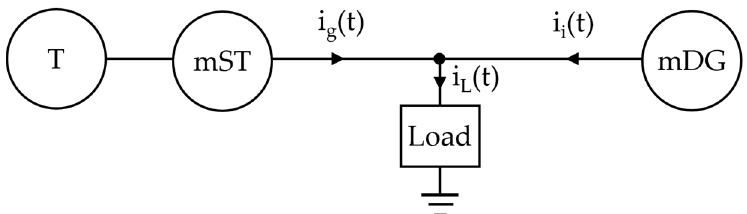
Figure 7. Configuration of test line .